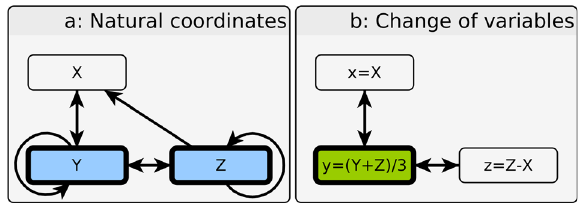
Fig. 1 Network structure and minimal feedback vertex sets of Eqs. 2 and 3. In this example, Eq. 2 is written in a privileged, or natural set of coordinates that correspond to the activities of individual biomolecules. The minimal feedback vertex set of Eq. 2 is unique, and consists of variables Y and Z , highlighted in blue in the network on the left (panel a); in addition, all feedback vertex sets contain this as a subset due to the self-regulation of these two variables. This implies that overriding Y and Z is suf fi cient to attain either of the system ’ s two attractors. Furthermore, in this example, this control set is minimal. A change of variables (depicted in panel b) gives rise to a system with a smaller feedback vertex set, consisting only of a single variable, y ¼ Y þ Z ð Þ = 3 , highlighted in green. However, in order to achieve the necessary override of y in the laboratory, Y and Z must both be manipulated. This example illustrates the importance of the natural coordinates of the system when designing control